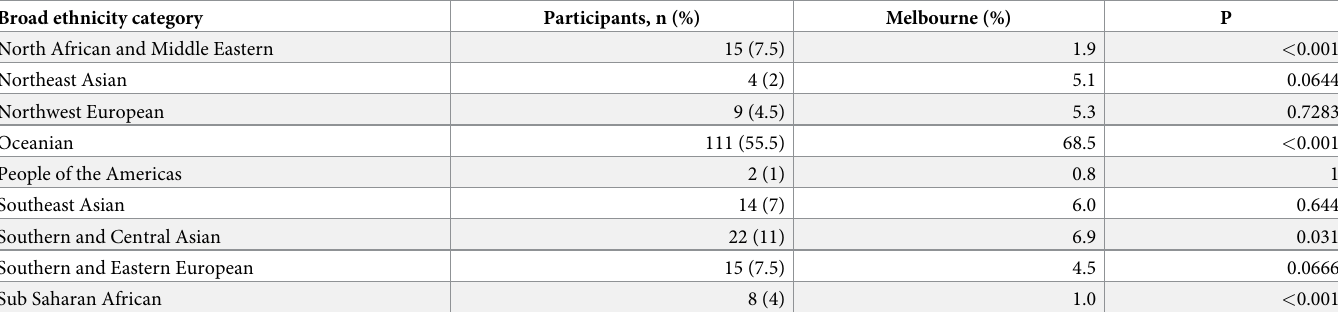
Table 2. Australian Bureau of Statistics Australian Standard Classification of Cultural and Ethnic Groups broad group classification of